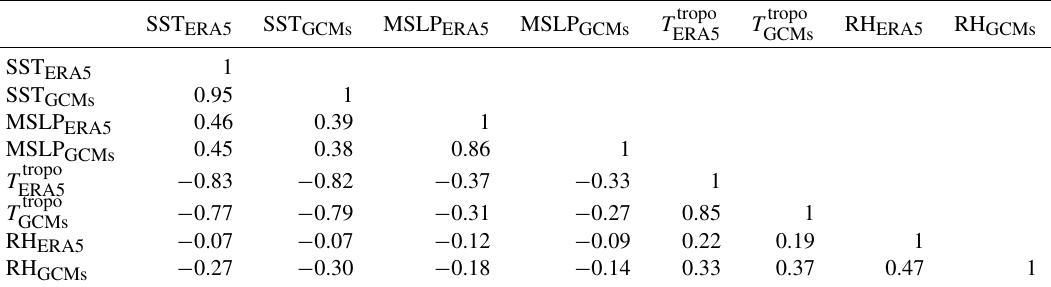
T tropo RH ERA5 RH GCMs ERA5 GCMs